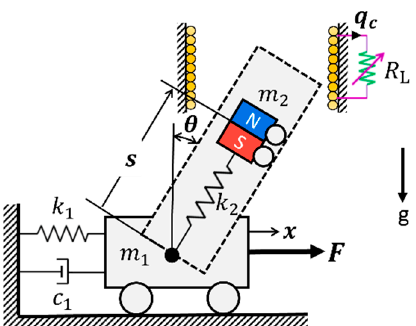
Figure 2. Equivalent lumped-mass model of the proposed tunable wind